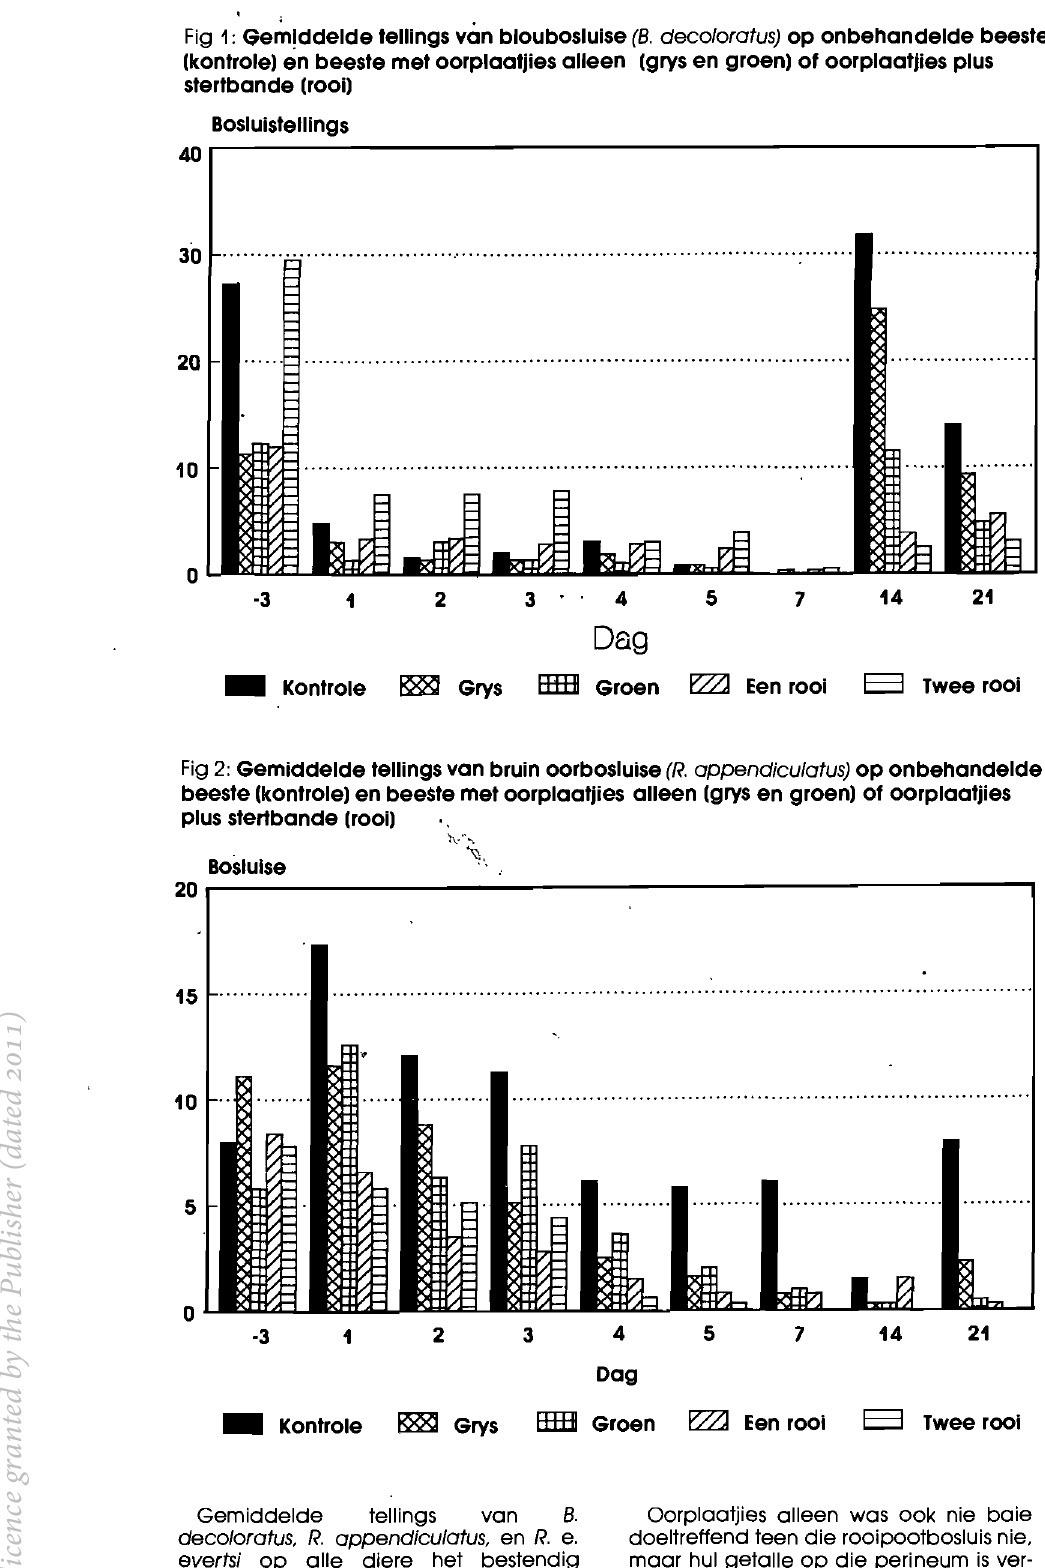
tellings van B. decoloratus, R. appendiculatus, en R.